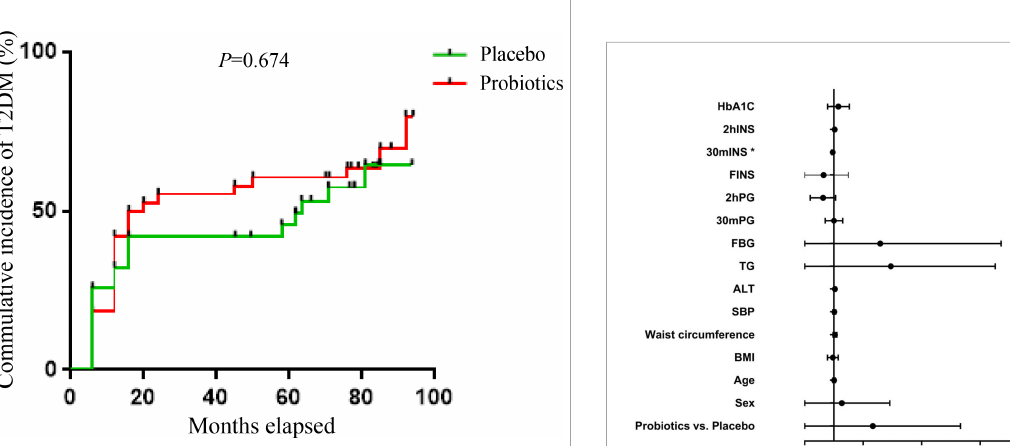
FIGURE 2 Kaplan-Meier analysis of the cumulative incidence of T2DM within 6 years between the probiotics and placebo group.